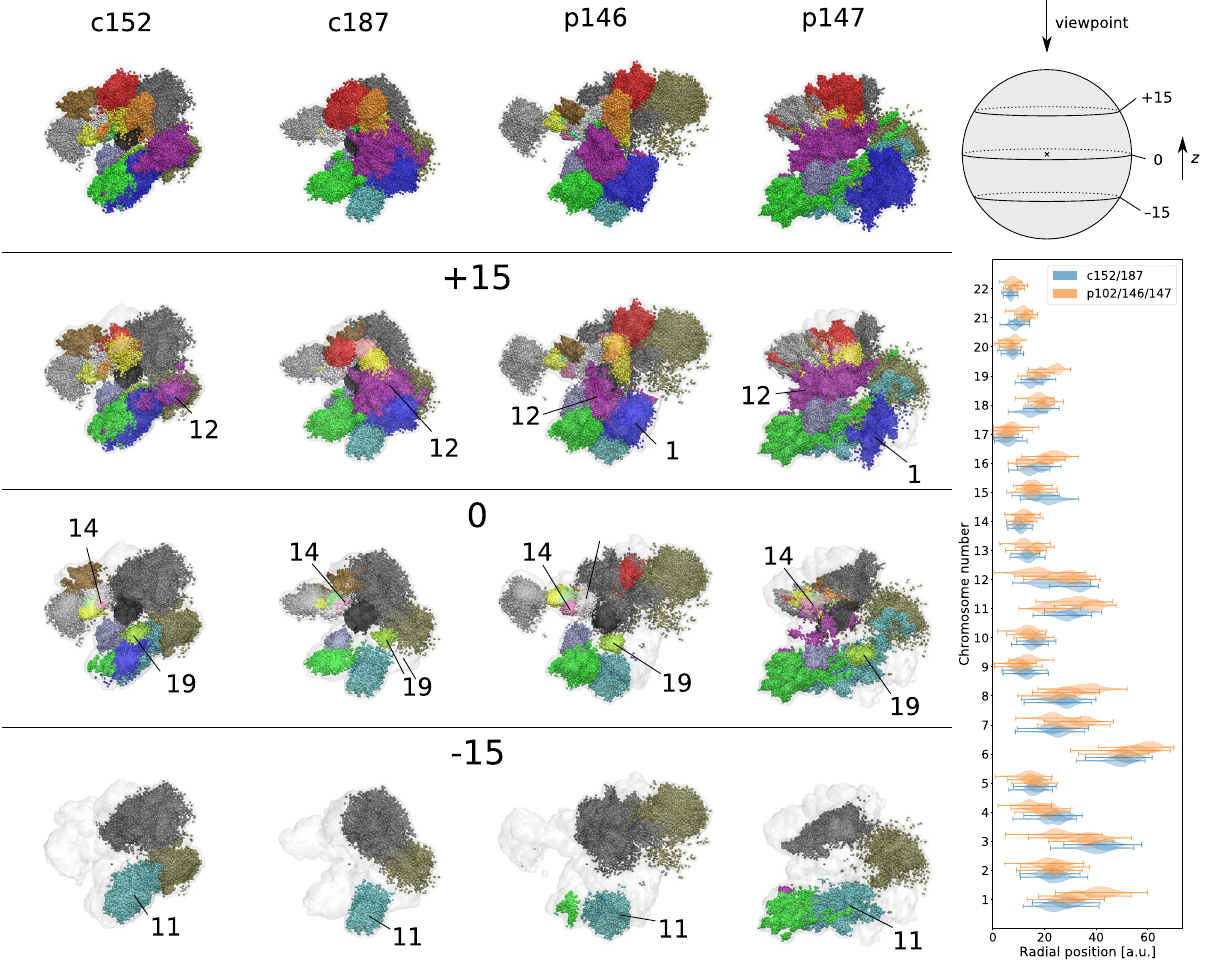
Figure 1. Reconstructions of whole-genome chromatin ensemble for olfactory sensory neurons in SARS-CoV- 2-infected patients and controls. Left, top row: Full reconstructions colored by chromosomes are shown for controls (c152, c187) and patients (p102, p146, p147). (Bottom left) Subsequent rows below are cross-sectional views of the respective reconstructions, at the positions indicated by the schematic (top right), where z = 0 intersects the centroid. The approximate centers of chromosomal territories 1, 9, 11, 12, 14, and 19 are indicated on the cross sections. Radial distributions of chromosomal territories, comparing the same chromosomes on control (blue) and patient (orange)